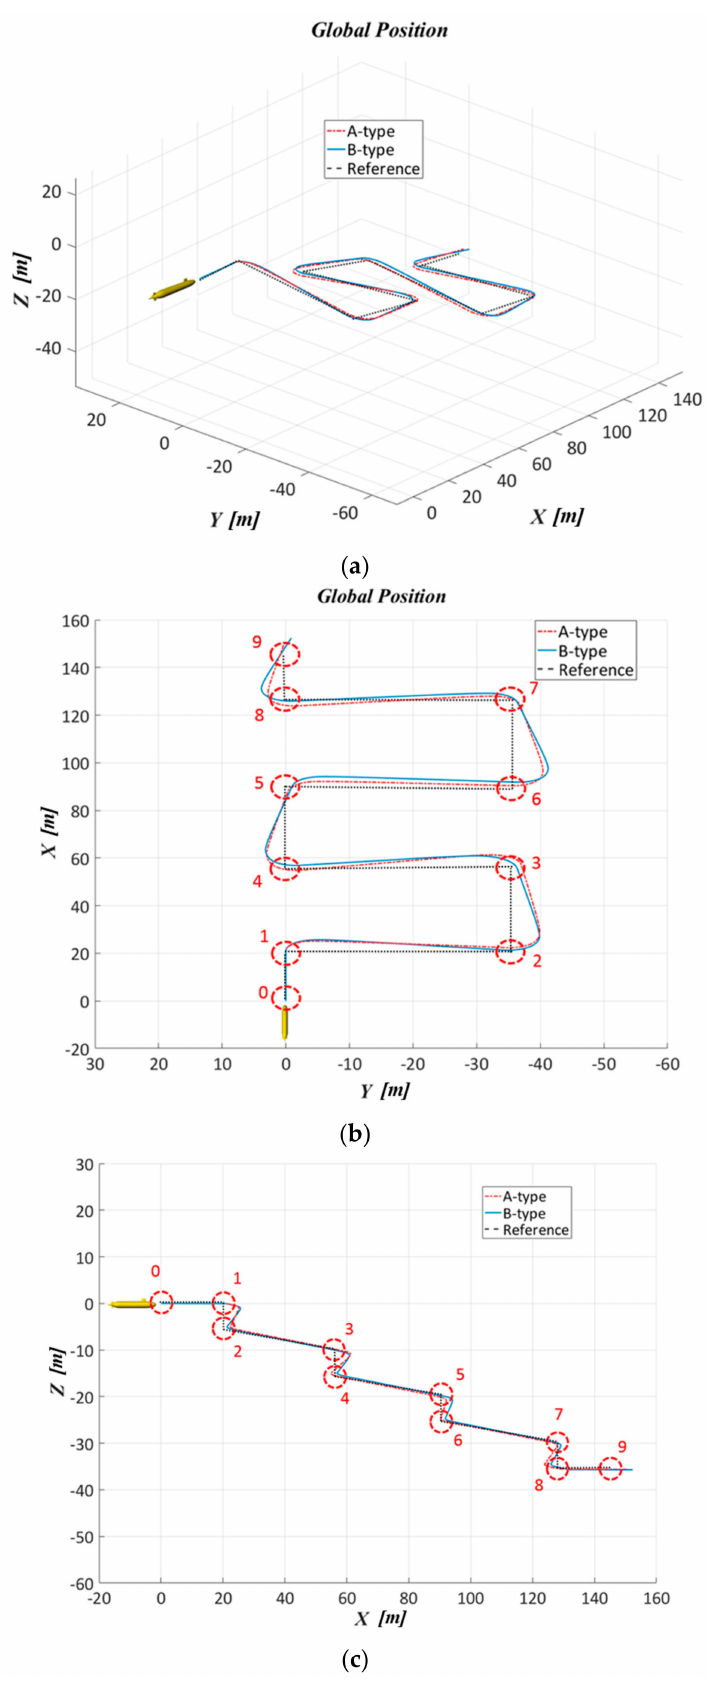
Figure 25. Sailing trajectories of the SFRM by comparing the A-type controller with the B-type controller in ( a ) the stereo view; ( b ) the top view; and ( c ) the side view,